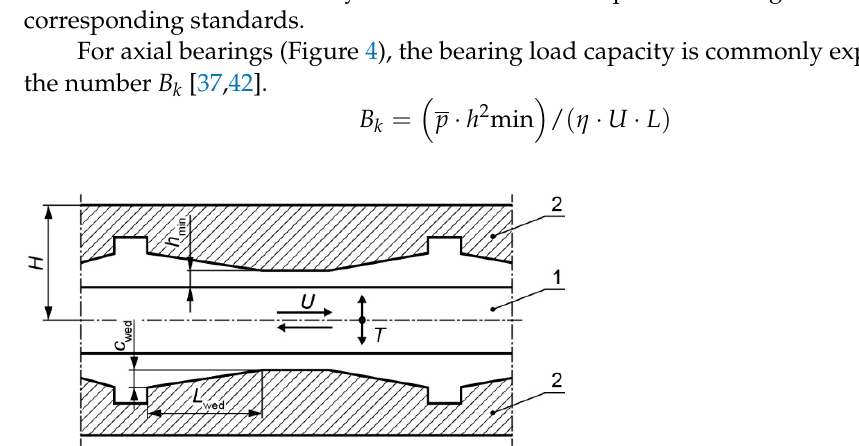
Figure 4. Model of the axial bearings with permanent wedges for work in both directions of force T and speed U : 1—shaft flange, 2—shells attached to the machine body, T —axial force exerting load on the bearing, U —linear speed of a point on the rotating shaft flange, h min —minimum height of the separating gap (minimum thickness of the oil film), L wed —length of the permanent wedge, C wed— height of the permanent wedge.